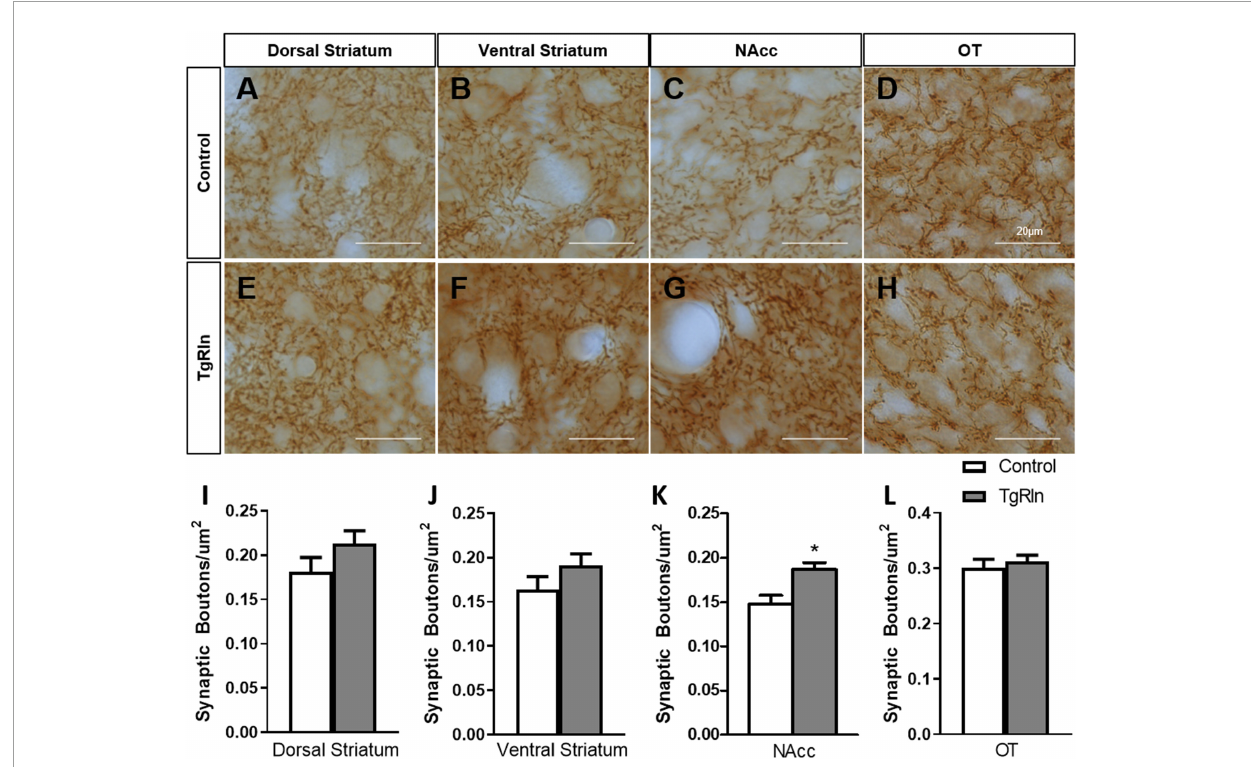
FIGURE6 Increased number of dopaminergic synaptic boutons in the NAcc of TgRln mice. (A–H) Immunohistochemistry for TH staining dopaminergic synaptic boutons in the dorsal (A,E) and ventral regions (B,F) of the DS, NAcc (C,G) , and OT (D,H) of TgRln mice and its controls. (I–L) Quantification of the density of dopaminergic boutons evidenced a higher density of synaptic boutons in the NAcc (K) of TgRln mice compared to its controls while no differences were observed in the rest of the analyzed structures (I,J,L) . Scale bar: (A–H) , 20 µ m. DS, dorsal striatum; NAcc, nucleus accumbens; OT, olfactory tubercle. Statistical analyses were performed using Student’s t -test; * p < 0.05. Data are represented as means ±